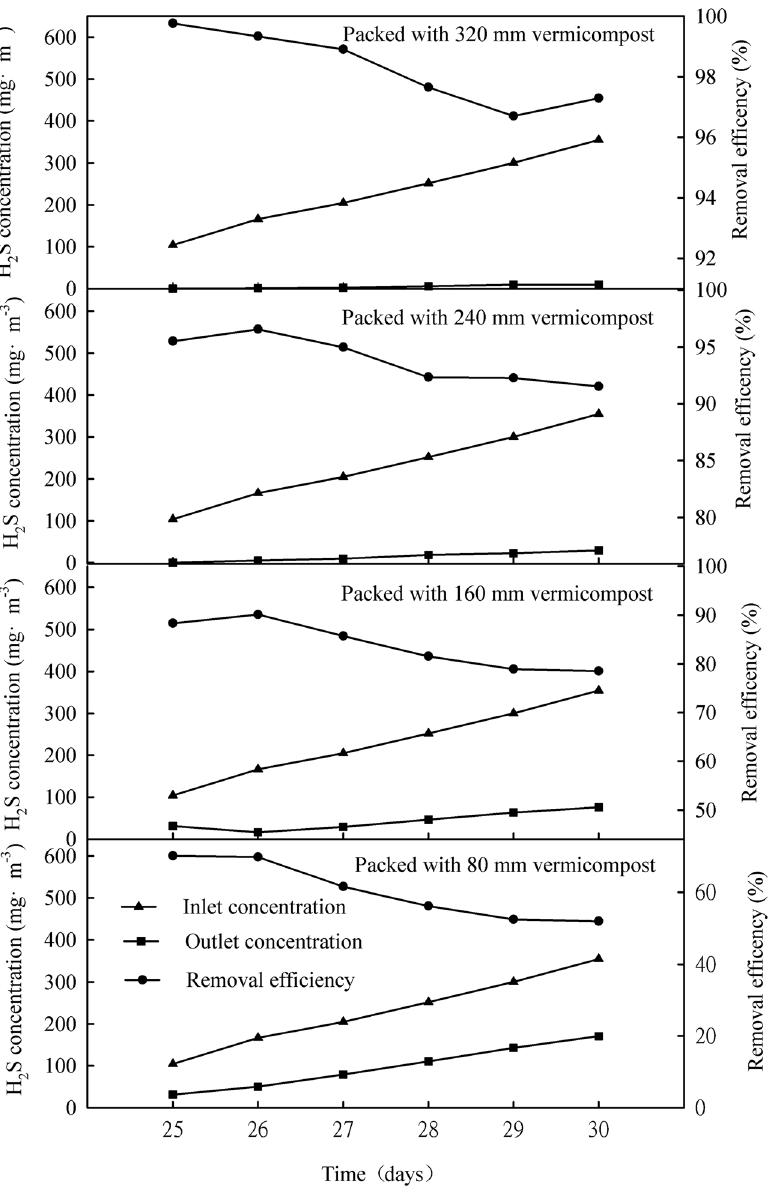
Figure 3: The concentrations and removal e ffi ciencies of H 2 S along the bioreactor packed with